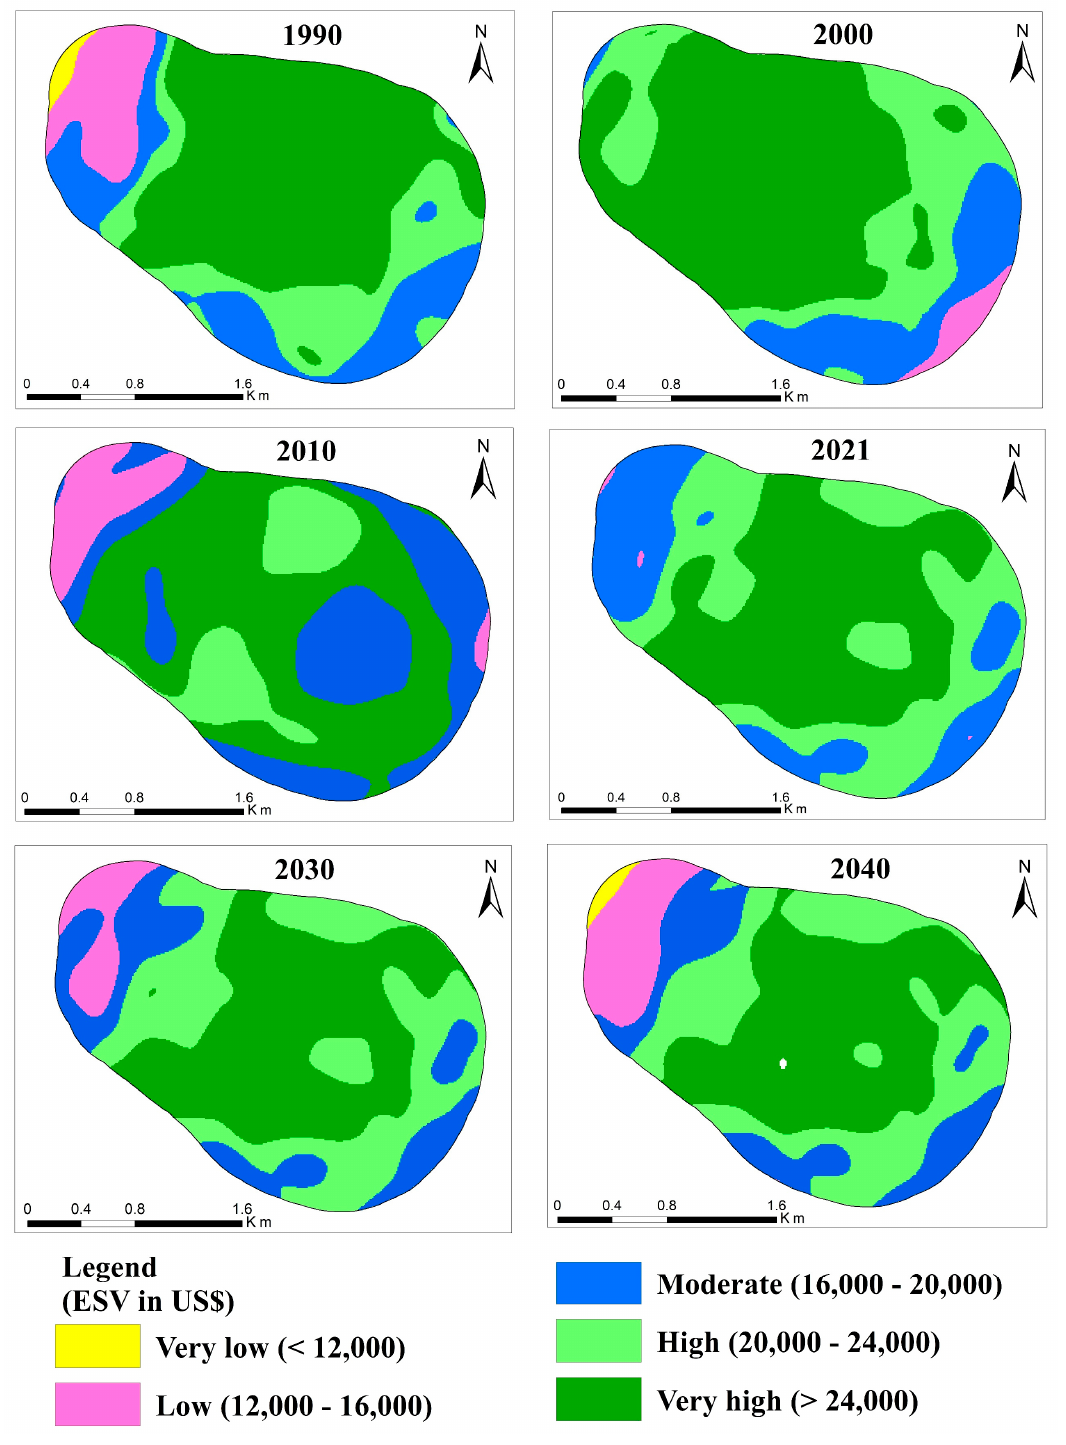
Figure 4. Spatio-temporal di ff erences of the ESV (in USD 10 3 ) based on Costanza et al. (1997).